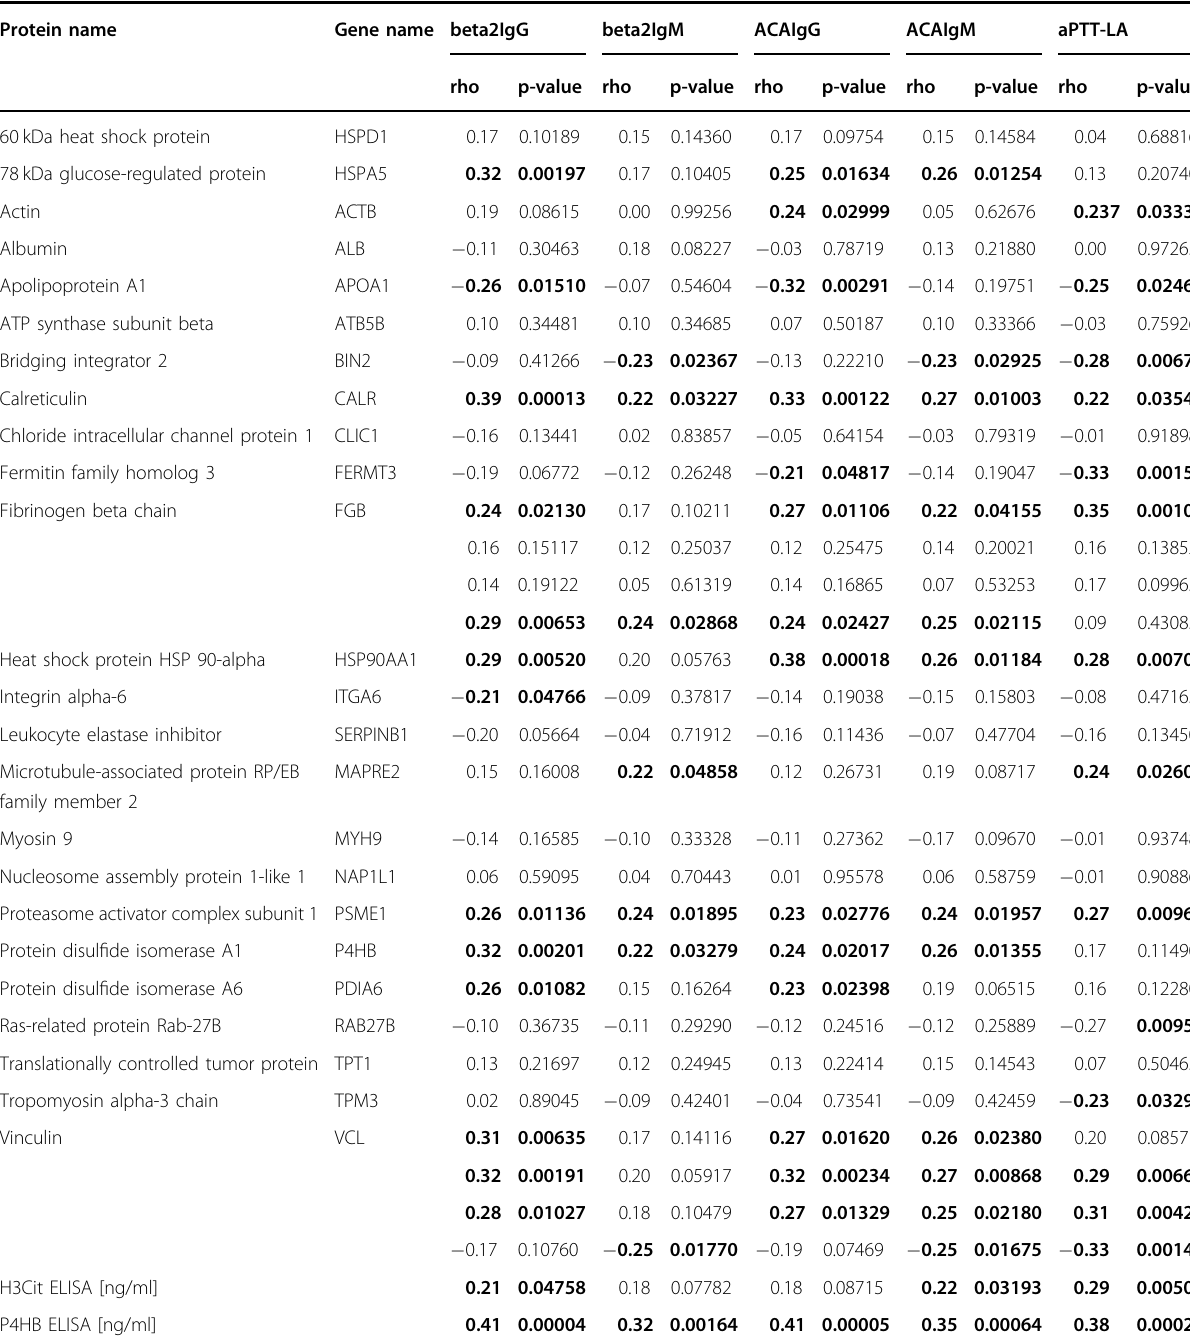
Table 3 Spearman correlation coef fi cients of altered platelet proteins and plasma levels of H3Cit and P4HB with